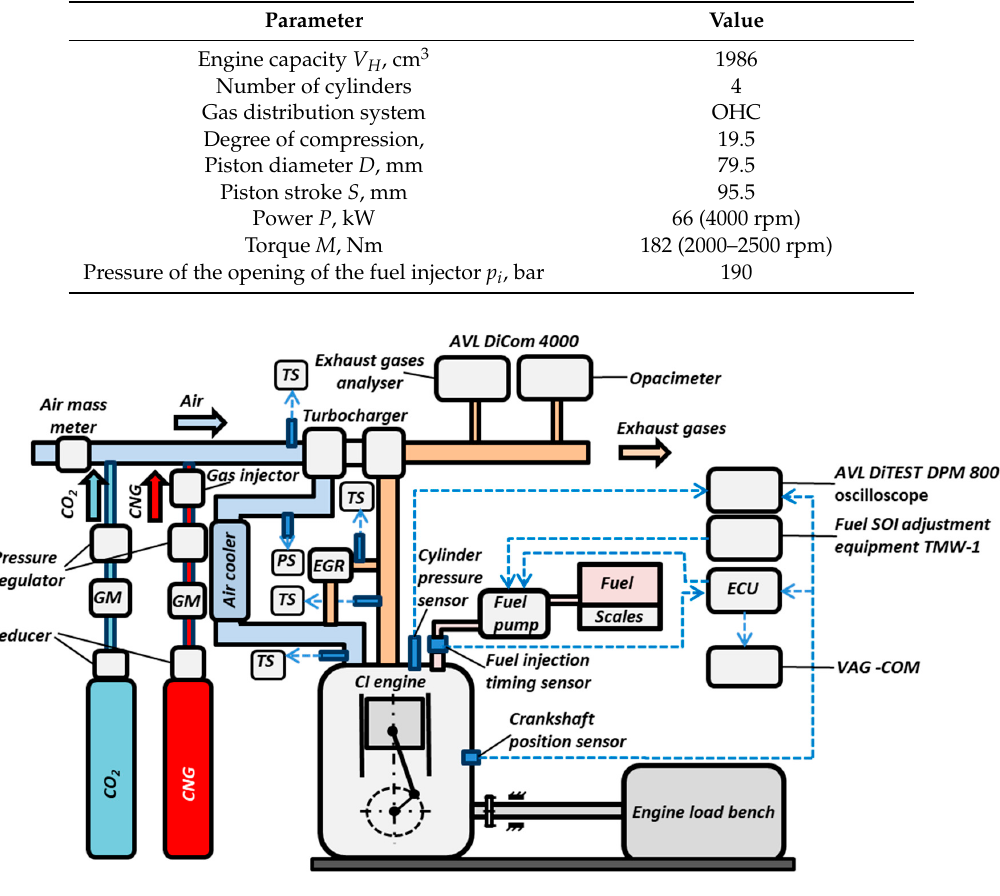
Figure 1. Engine test equipment.